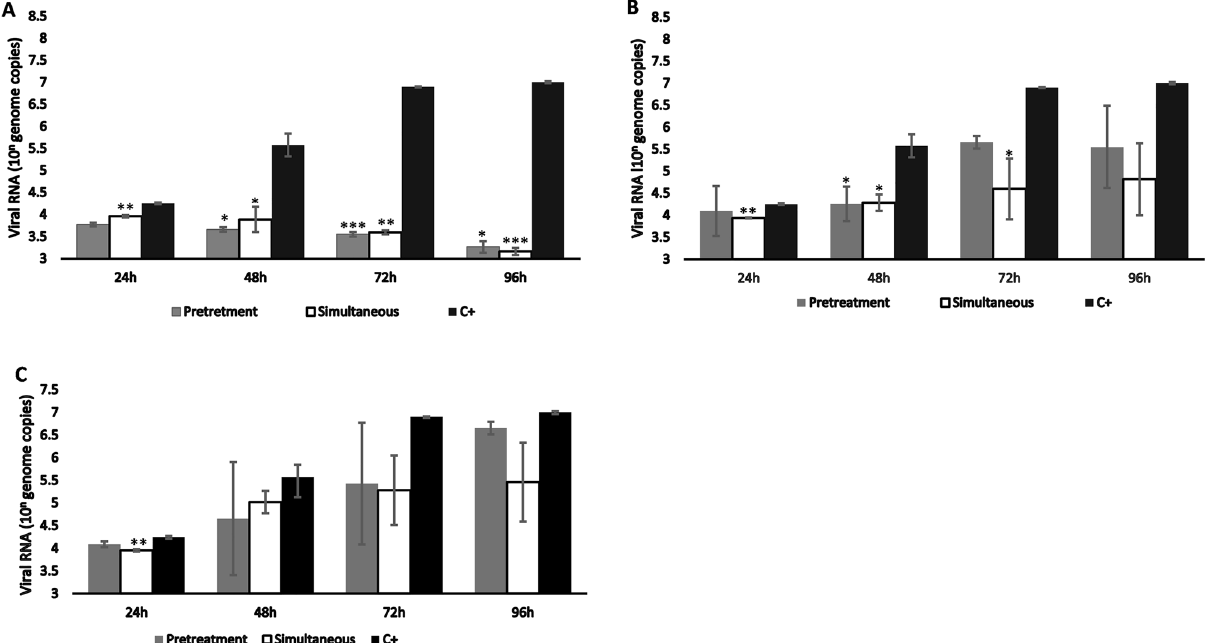
Figure 2. Quantification of viral load after infection. Mean values and mean ± SEM are shown. ( A ) C. vulgaris . ( B ) A. maxima . ( C ) fucoidan. Statistical significance is indicated by * P value < 0.01, ** P value < 0.001 and *** P value of <